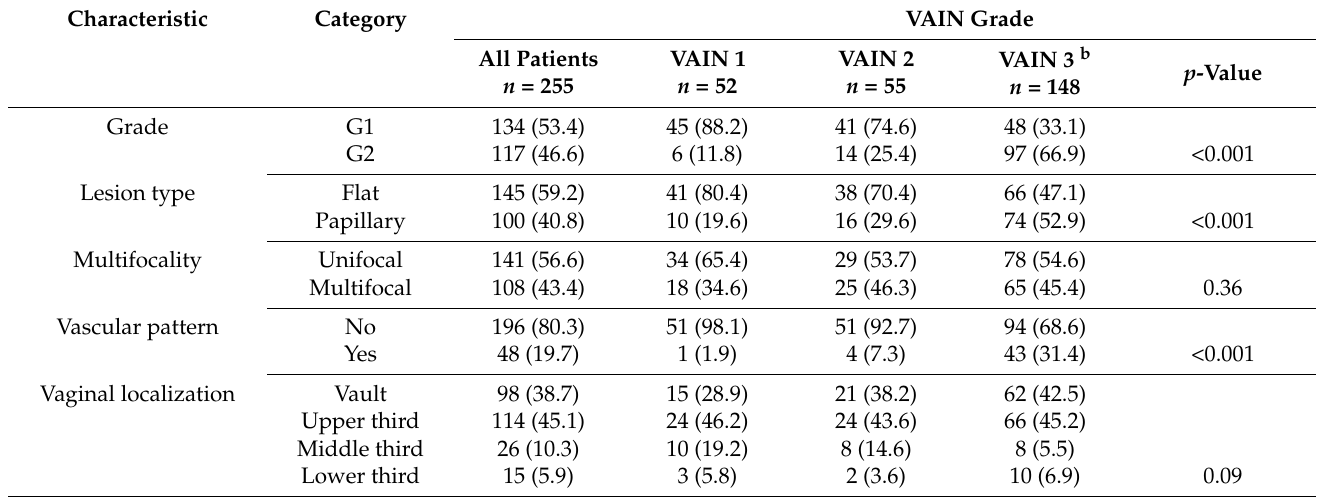
Table 2. Patients’ colposcopic features summary statistics a by VAIN grade at diagnosis.